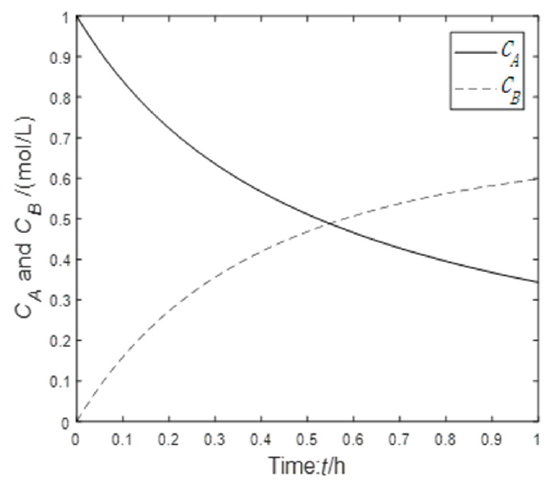
Figure 4. Optimal temperature control trajectory ( N = 30).